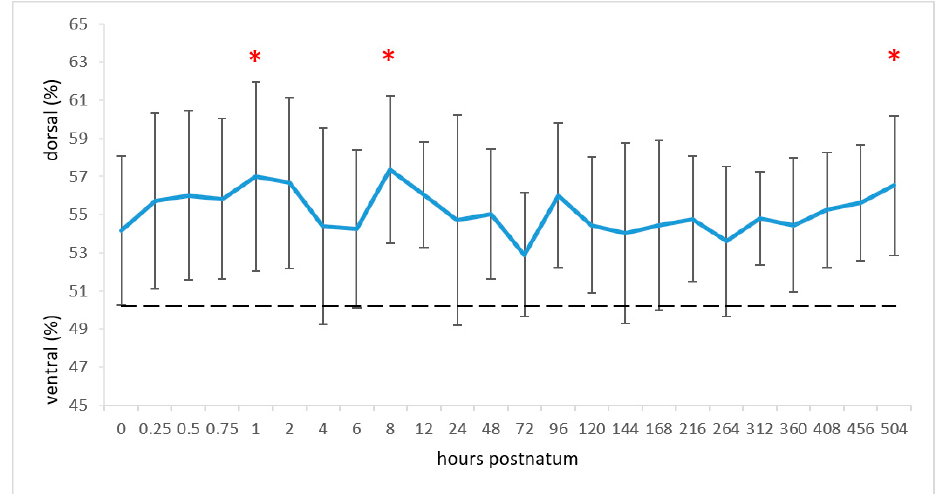
Figure 3. Means and standard deviations of the centre of ventilation (CoV; blue line) in the ventrodorsal lung diameter and CoV for equal distribution between the ventral and dorsal regions (black dashed line). The measuring times are graphed equidistantly. Values with an asterisk differ from the value at time